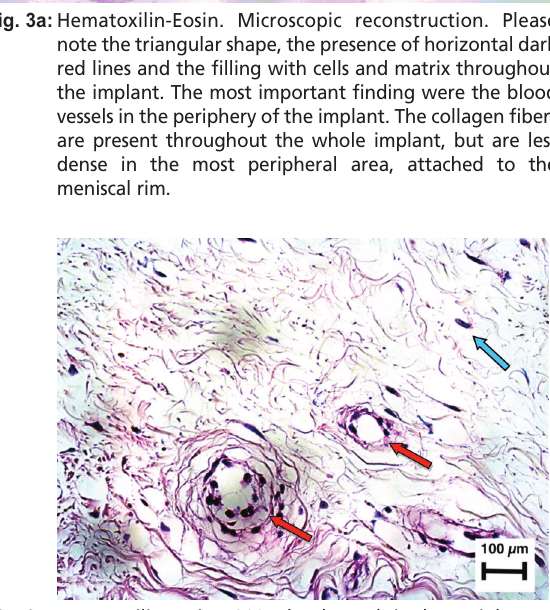
Hematoxilin-Eosin x 200. Blood vessels in the periphery of Fig. 3c: the implant. Not only were there fibro-chondrocytes filling the spaces between the collagen mesh, but also these cells escaped the mesh, covering it and making it longer. The vessels (red arrows) and the fibro- chondrocytes (blue arrow) are seen.